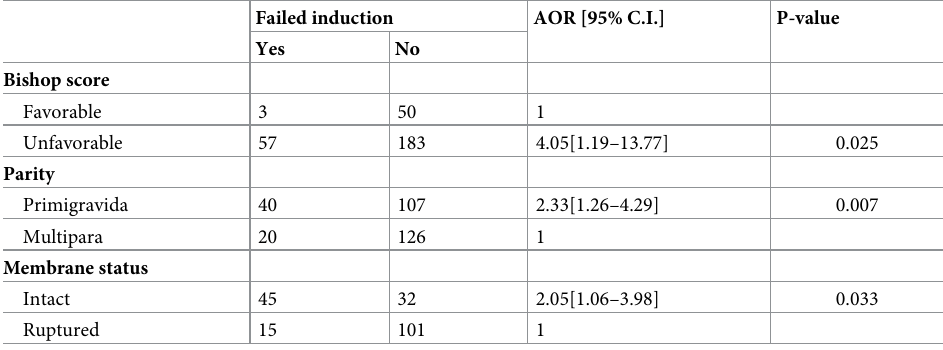
Table 5. Multivariable logistic regression analysis showing factors associated with failed induction in Adama Hos- pital Medical College, East Shoa, Oromia, Ethiopia, 2020, (n = 293). Failed induction AOR [95%